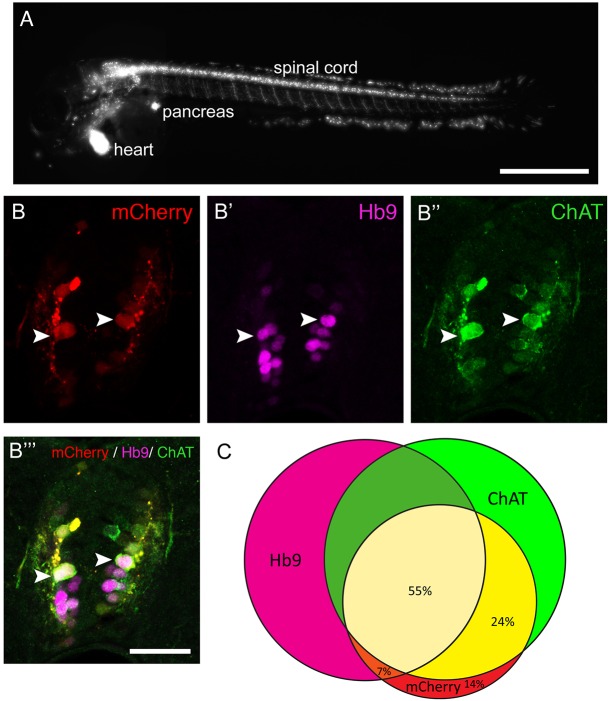
The Tg(mnx1:Gal4, UAS:nfsB-mCherry) transgene is expressed in motor neurons. (A) Lateral view of a whole larva (rostral left, dorsal up, 3 dpf) indicates labelling in spinal motor neurons, the pancreas and heart. (B,C) Spinal cross sections (3 dpf) indicate that most mCherry+ cells are also Hb9+ or ChAT+, or both. Arrowheads indicate triple-labelled cells. (C) Venn diagram showing the overlap of mCherry expression with motor neuron markers. Scale bars: 500 µm in A; 25 µm in B‴ for B-B‴.